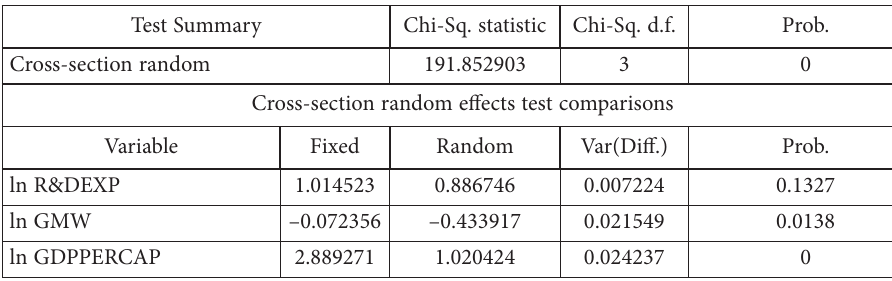
Table 3. Summary of the Hausman test